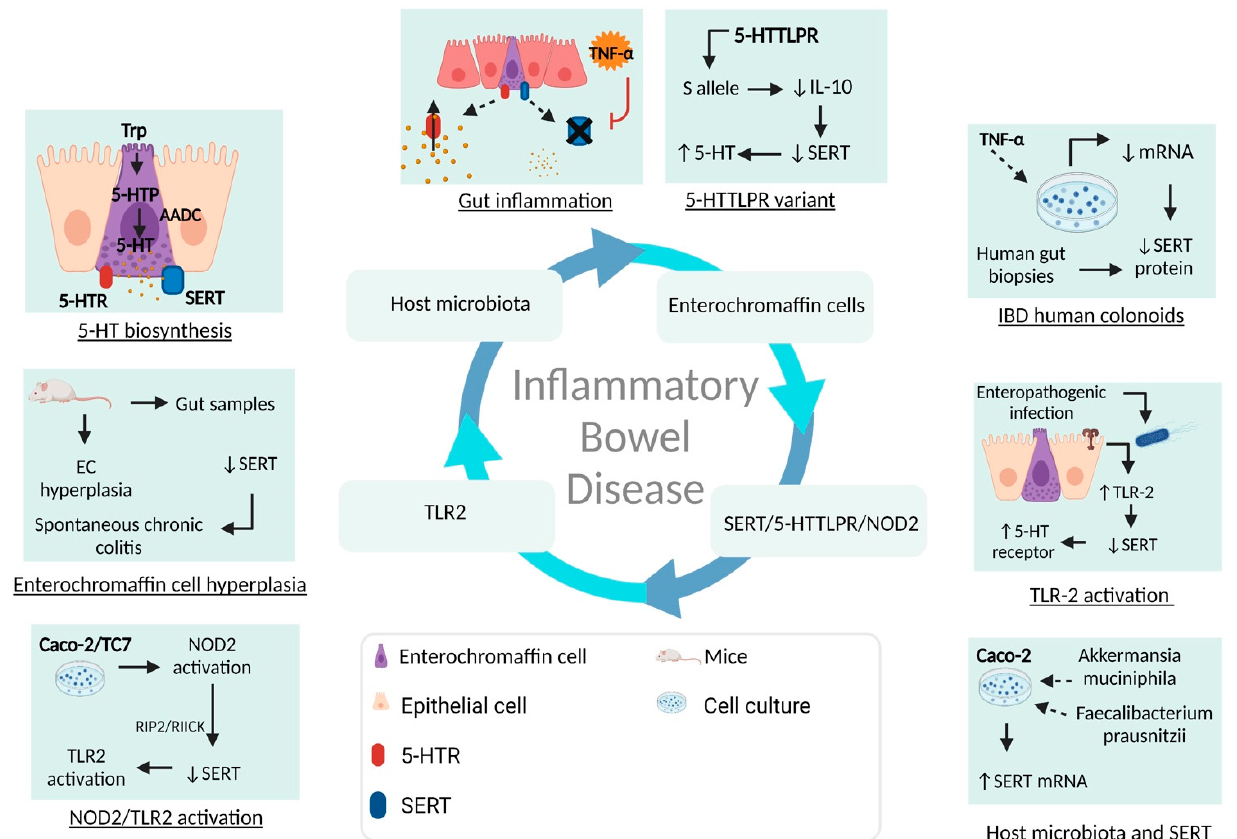
Figure 6. Overview of SERT, gut microbiota, and IBD pathogenesis. Serotonin is a monoamine exerting a wide range of biological effects through the intestinal microbiota, serotonin receptors, and SERT. After the biosynthesis of serotonin in enterochromaffin cells, there is the possibility that, in the context of gut inflammation, SERT may be affected by different pro-inflammatory mediators and bacteria, leading to dysregulation of mRNA, SERT proteins, and serotonin bioavailability. Trp, tryptophan; 5-HTP, 5-hydroxytryptophan; NOD2, Nucleotide oligomerization domain 2; TLR-2, Toll-like receptor 2; EC, enterochromaffin cells.